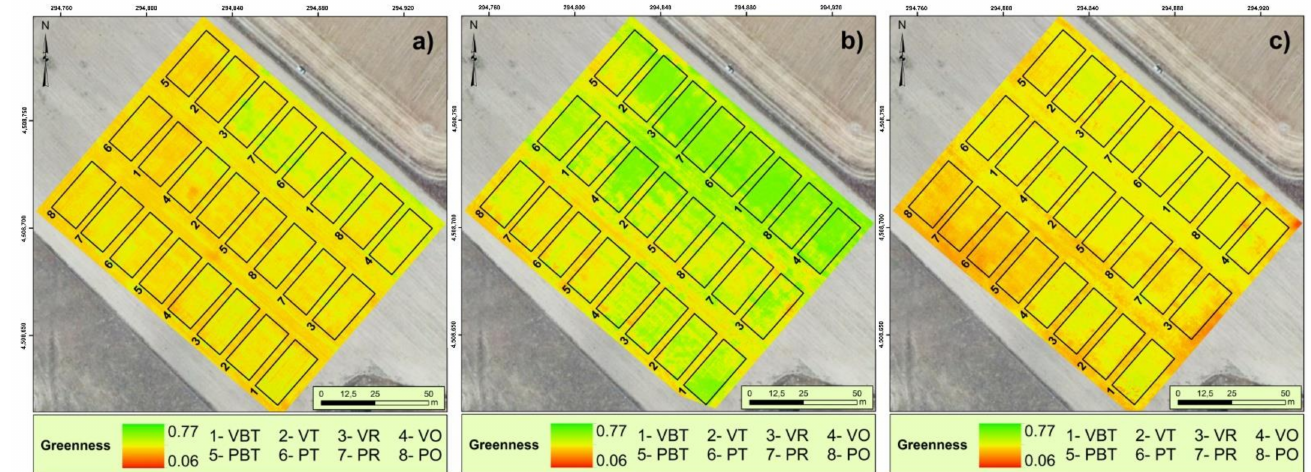
Figure 5. Temporal evolution of Gr index in three growing cycle points: ( a ) 26 February 2020, ( b ) 2 May 2020 and ( c ) 5 May 20. VBT: vetch-barley-triticale, VT: vetch-triticale, VR: vetch-rye, VO: vetch-oats, PBT: pea-barley-triticale, PT: pea-triticale, PR: pea-rye and PO: